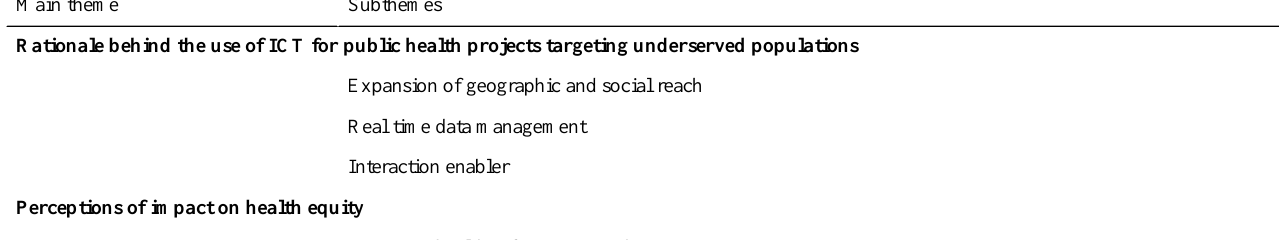
Table 2. Main themes and subthemes: Rationale behind ICT use, perceptions of impact on health equity, and challenges to program